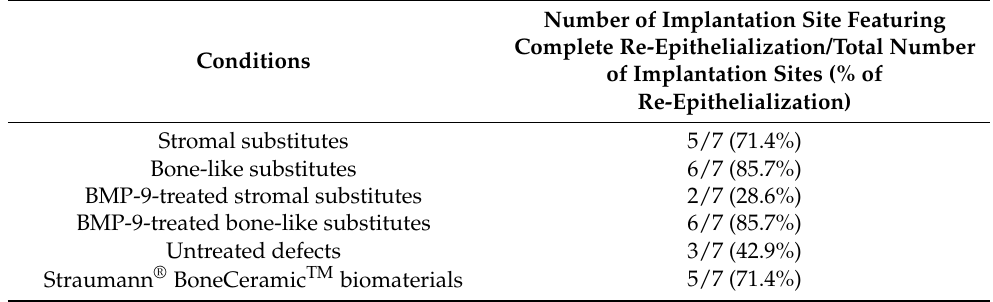
Table 1. Qualitative evaluation of gingival healing at the implantation sites ten weeks after grafting.